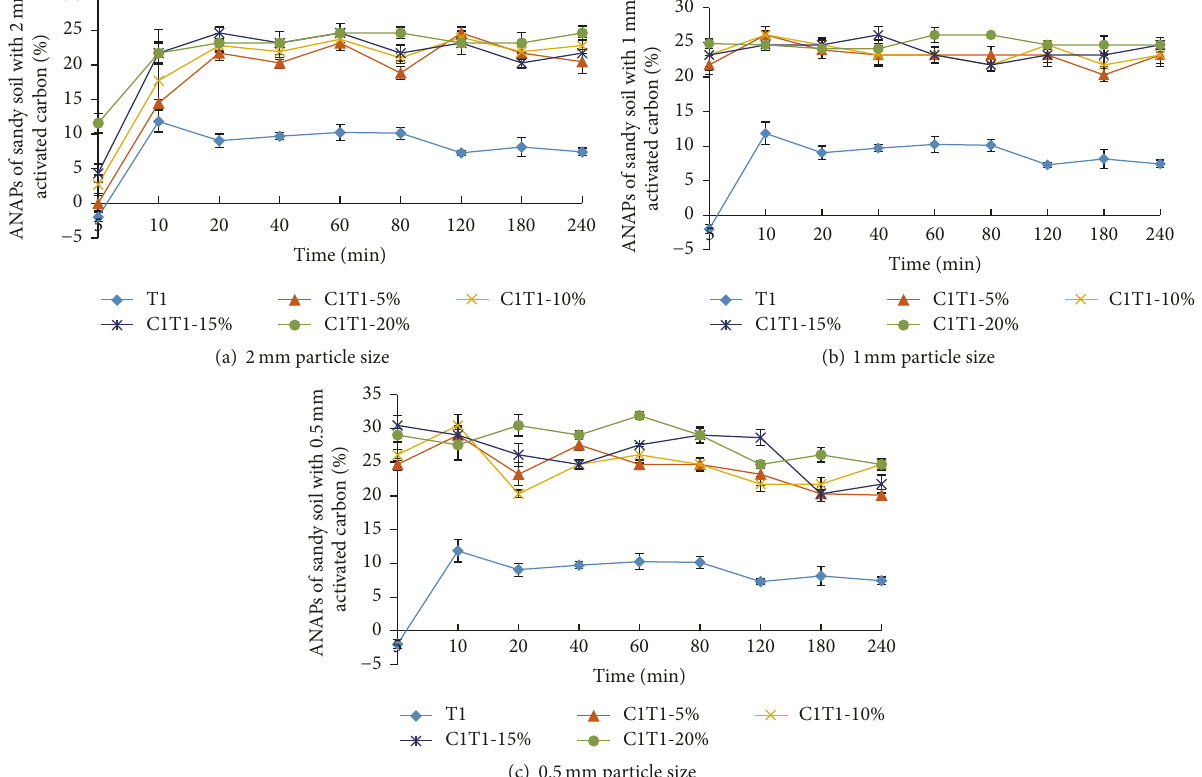
Figure 3: Effects of commercial activated carbon (C 1 ) on sandy soil adsorbing NH 4+ -N in biogas slurry when the particle sizes of activated carbon were 2 mm, 1mm, and